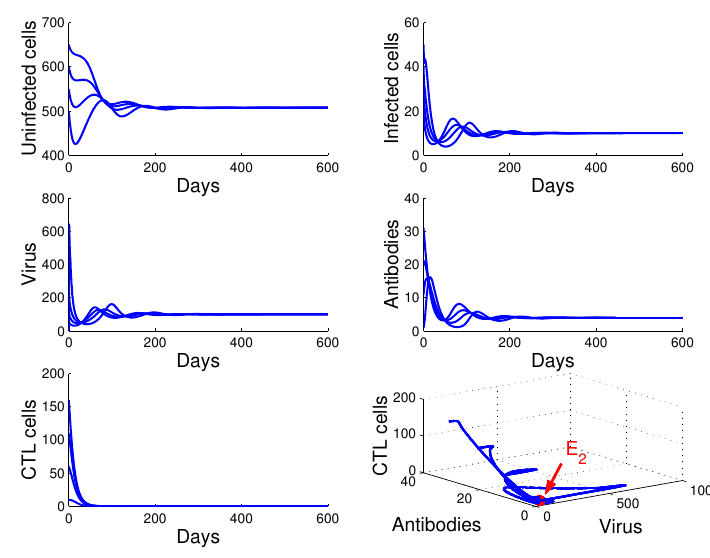
Figure 3. Demonstration of the global stability of the infection equilibrium with only humoral immunity = 2.5099 > 1, and R Z = 0.2000 ≤ 1. E 2 for R 0 = 1.8036 > 1, R W 2 1